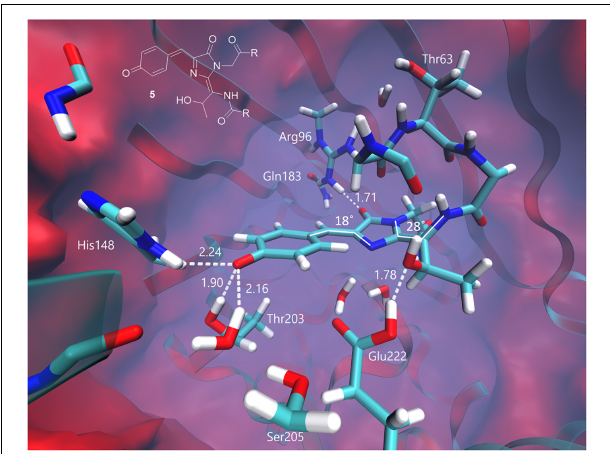
FIGURE 7 | Ground-state equilibrium structure of the quinoid-like form. Only the QM part is shown for clarity. All distances are shown in Å.